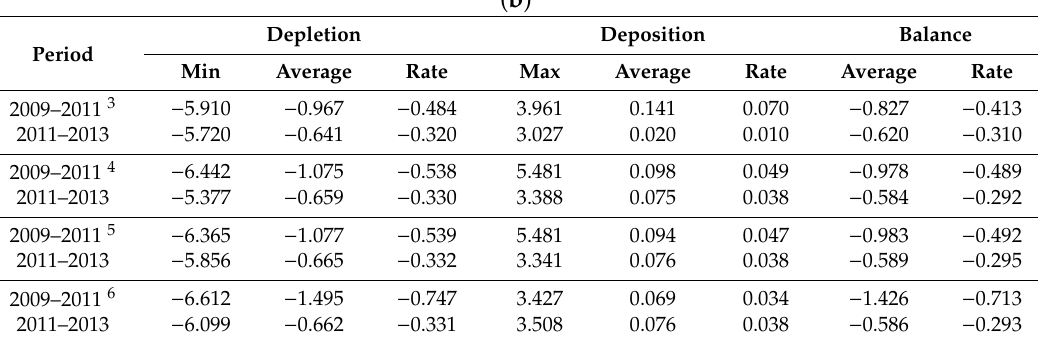
Table 8b. Height differences and rates in the gullies of the detailed area for edited DTMs 1,2 . Period